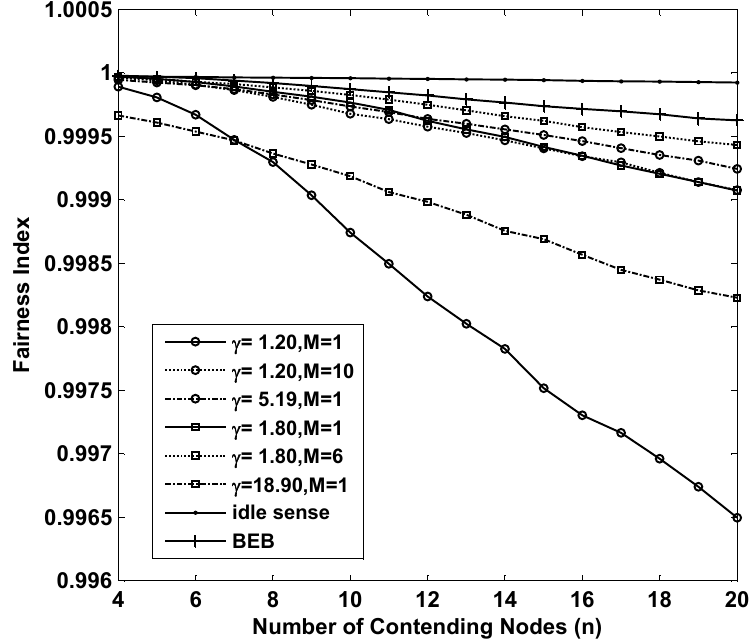
Figure 4. The fairness performance of M -level contention window tuning algorithm with different M and γ , idle sense algorithm and BEB for sparse deployed